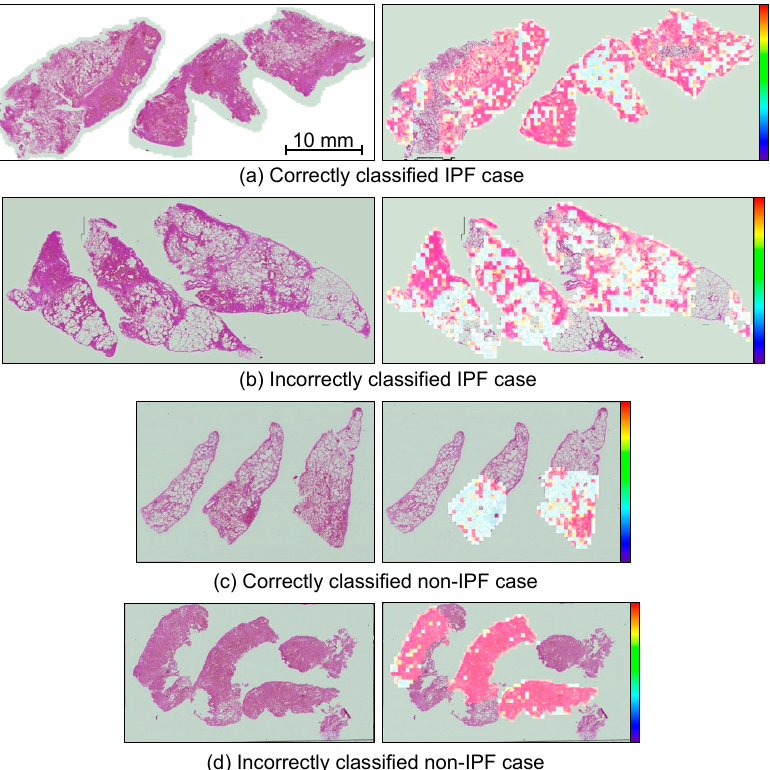
Figure 8. Probability map of classification. Red areas indicate a high probability of IPF. ( a ) Correctly classified specimens of IPF cases; ( b ) Incorrectly classified IPF case; ( c ) Correctly classified non-IPF case; ( d ) Incorrectly classified non-IPF